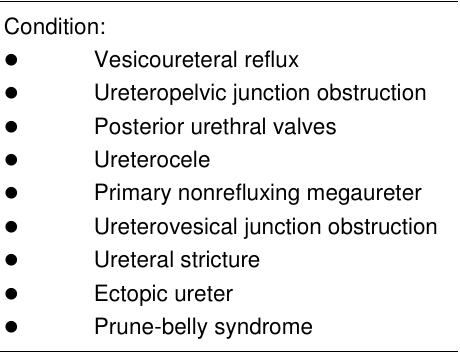
Differential Diagnosis of Prenatal